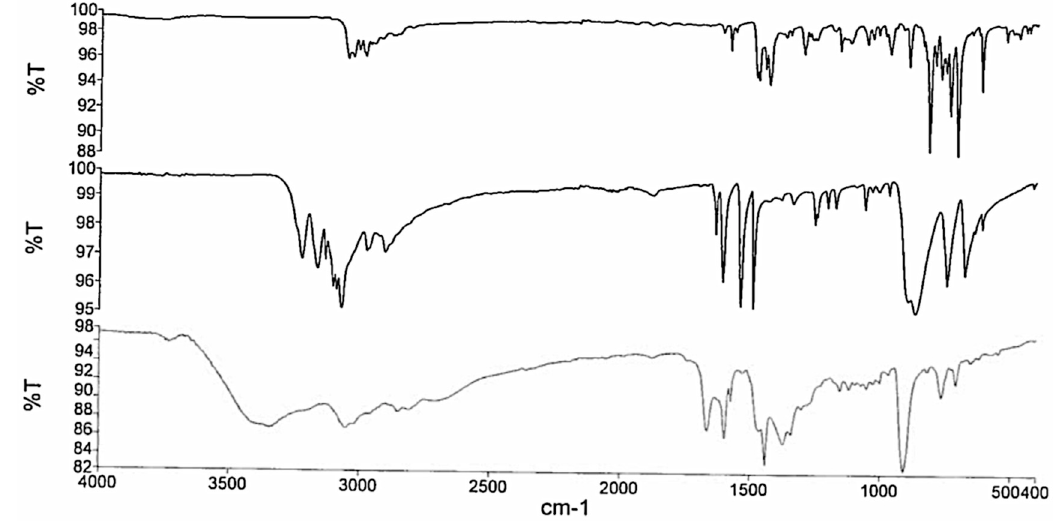
Figure 4. IR spectra of cis -[(BPMEN)ReO 2 ]BPh 4 , pyridinium perrhenate, and “water-treated” cis - [(BPMEN)ReO 2 ]BPh 4